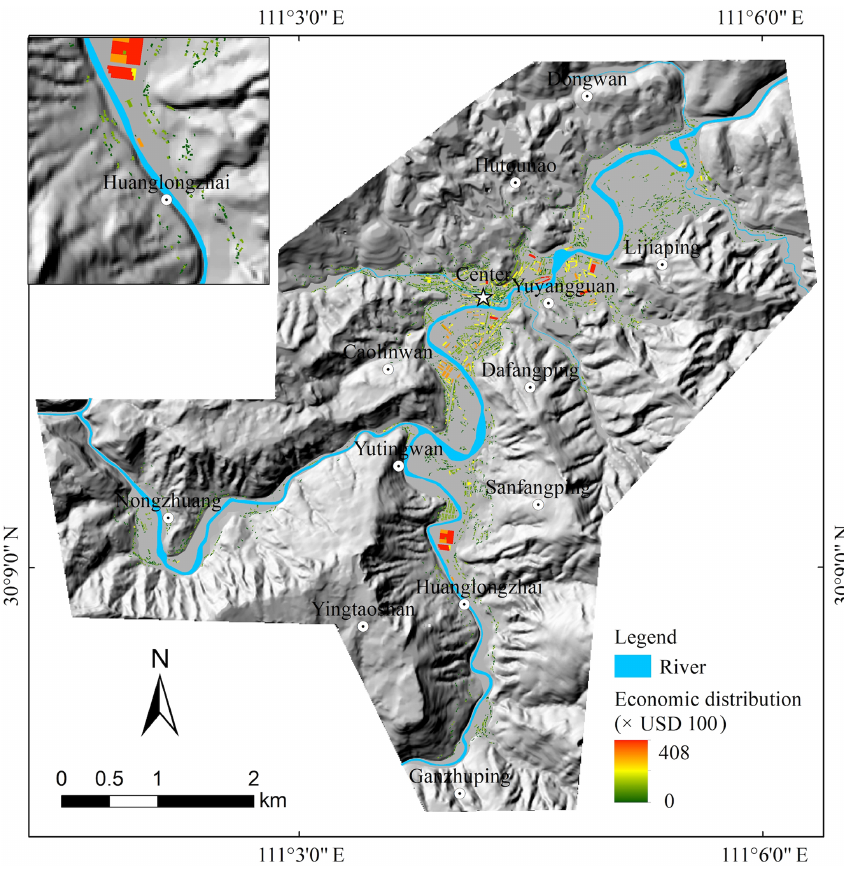
Figure 5. Building footprint map with economic values for the Yuyangguan